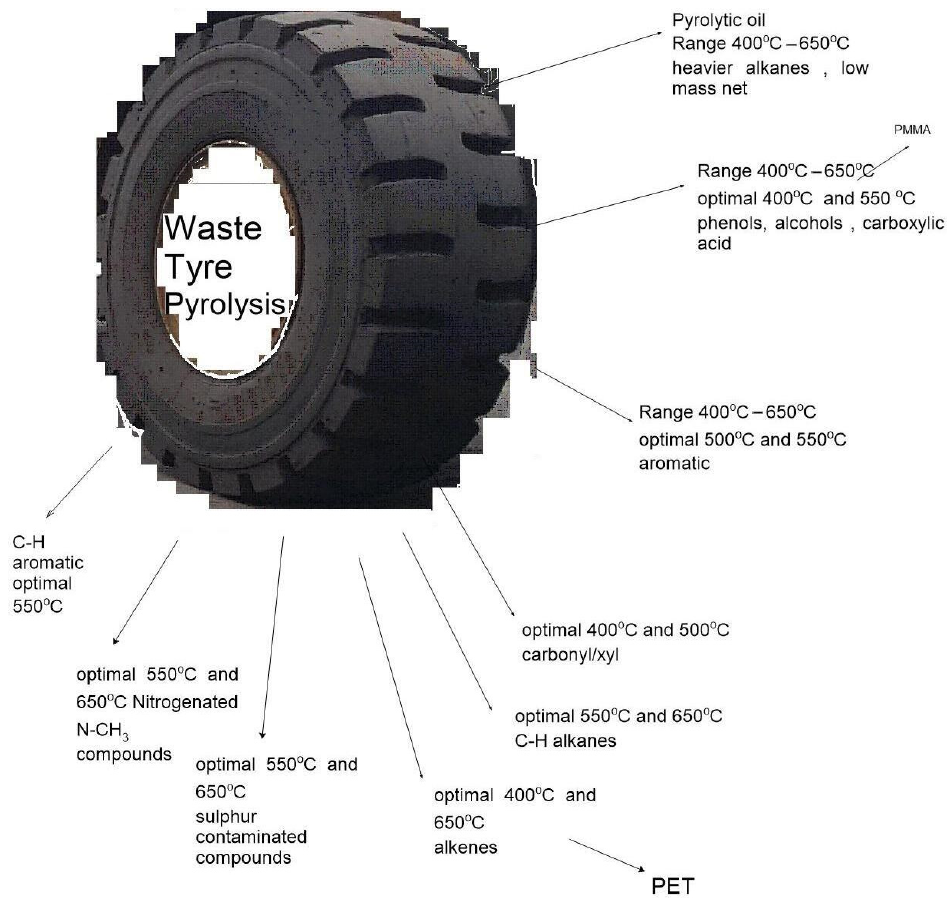
Figure 2. Tire pyrolysis and conditions for the design of selected products [119].